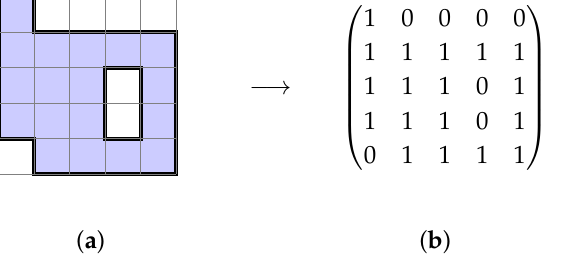
Figure 8. Constructing the binary matrix for R : ( a ) the target region R ; ( b ) binary matrix B